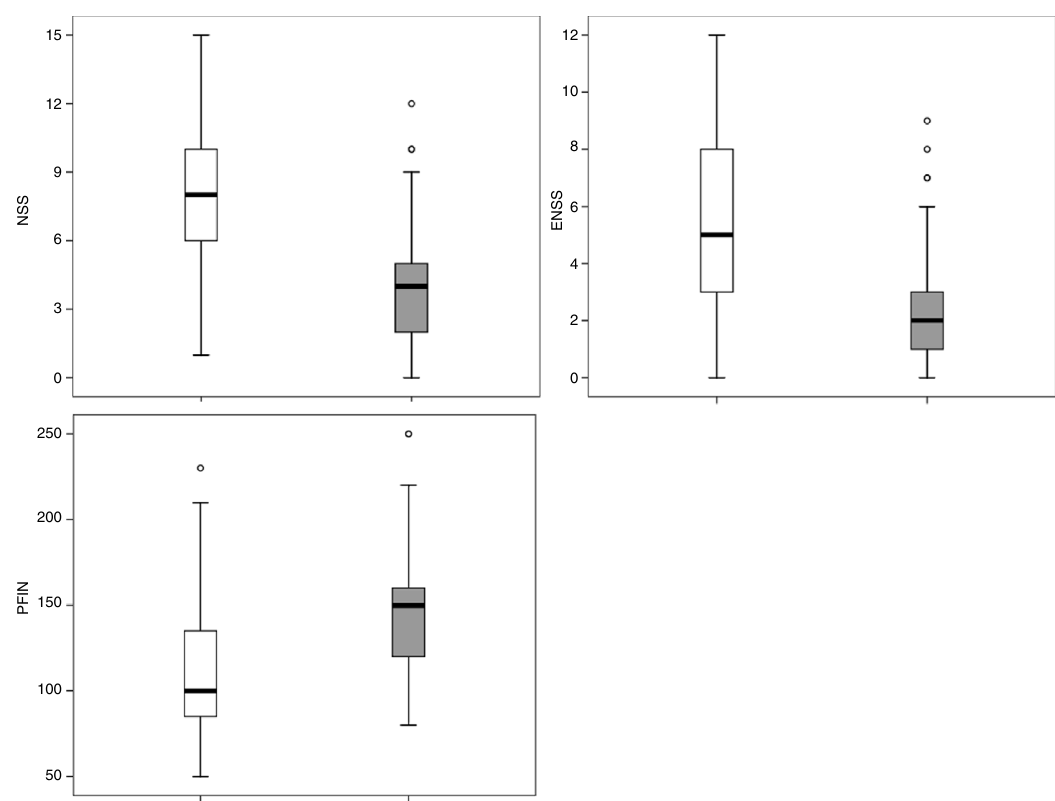
Figure 5 Score values of Nasal Symptom Score (NSS), Extra-Nasal Symptom Score (ENSS) and Peak Nasal Inspiratory Flow (PNIF) values of patients classified as controlled (gray; total score values of Rhinitis Control Assessment Test (RCAT) ≥ 22), or uncontrolled (white; RCATT